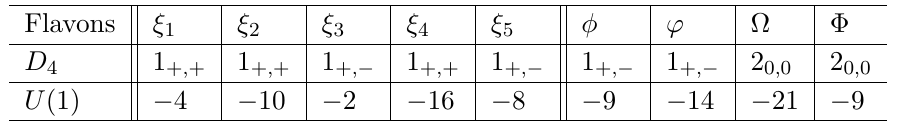
Table 2 . The D 4 × U(1) quantum numbers of the flavons used in the quark and charged lepton sec- tors.